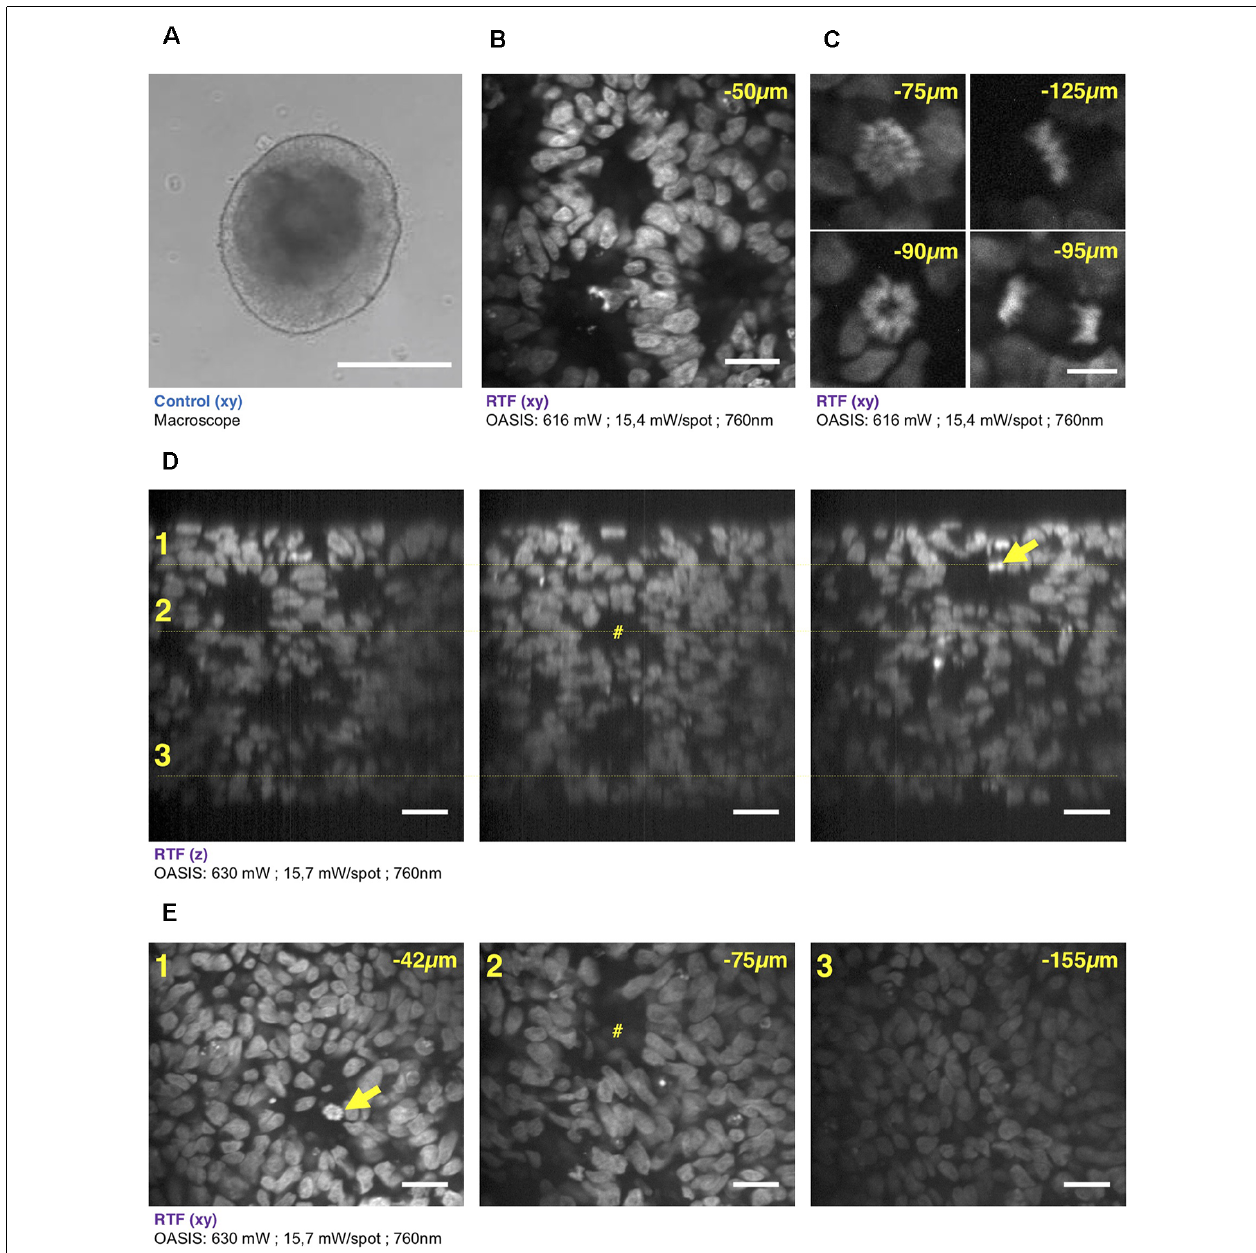
FIGURE 4 | 3-D imaging with the OASIS of the fine structure of embryonic bodies (EBs). (A) Macrophotography of a day-7 EB; Scale-bar, 300 µ m. (B) Image acquired in the center of the organoid after TO-PRO3 staining, 50 µ m below the surface. Scale-bar, 25 µ m. Note the presence of internal round structures with a lumen. (C) Zoom on mitotic figures observed in the EB at various depth ( top left : prophase; top right : metaphase; bottom left : early anaphase; bottom right : late anaphase); stain: TO-PRO3. Scale-bar for all panels, 10 µ m. (D) xz -pro-jections of a z -stack acquired across an entire day-7, TO-PRO3-stained EB. Scale-bar, 25 µ m. Arrow points to mitosis also visible in panel (E) . # Indicates ventricle-like structure also perceived in (E) . (E) xy -sections across the dotted lines shown in (D) at imaging depths of, respectively, 42 µ m (1), 75 µ m (2) and 155 µ m (3). Scale-bar, 25 µ m. With the exception of (A) , all images were acquired after RTF clearing.